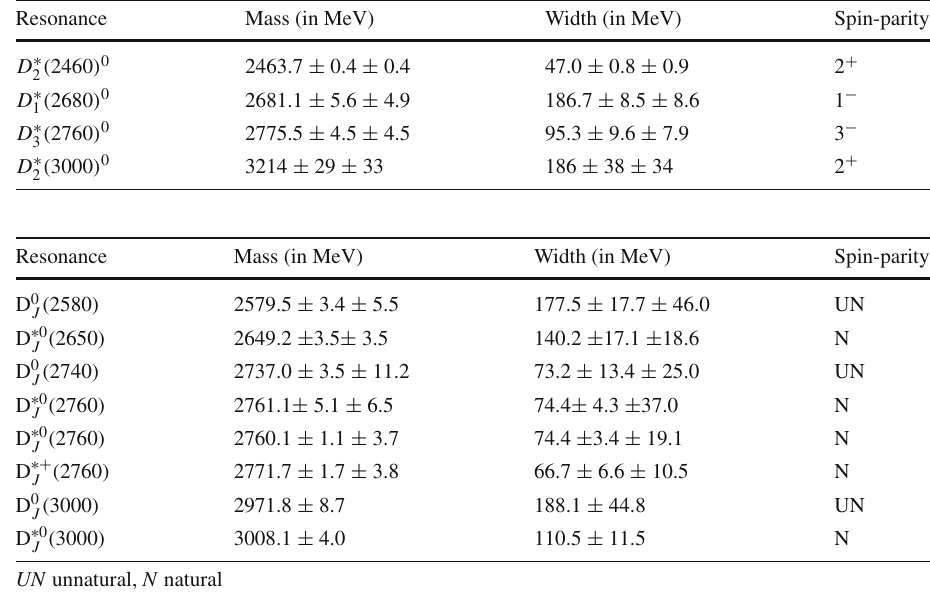
observed by BABAR Collaboration [3]